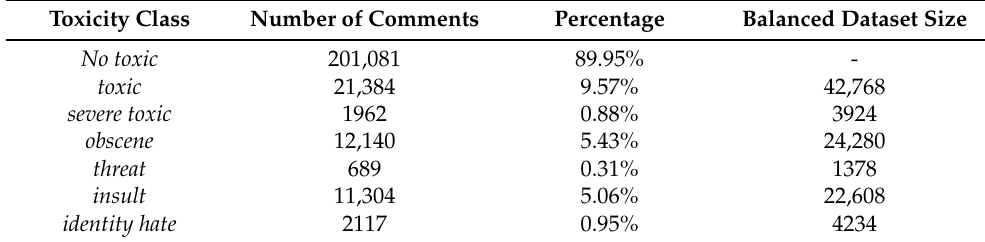
Table 1. Number of textual comments for each